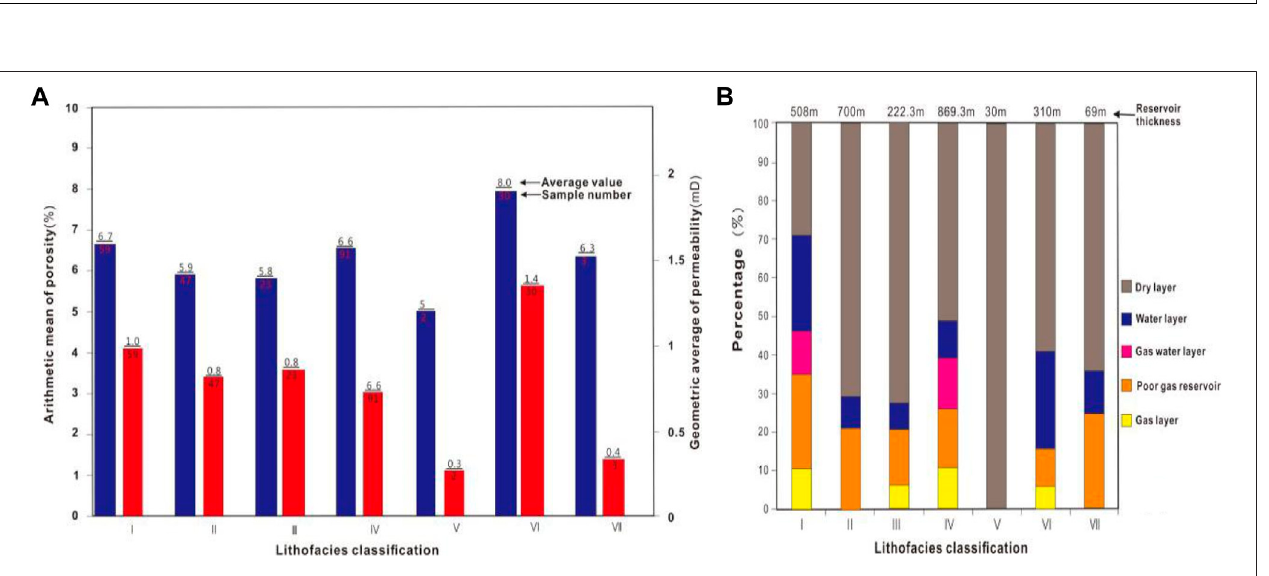
Frontiers in Earth Science |